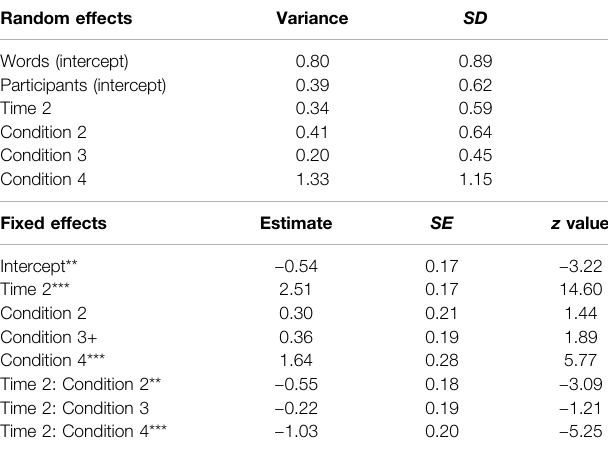
TABLE 8 | Results of the generalized linear mixed effects model for the performances of Chinese word and picture pairs (CP), Chinese word and